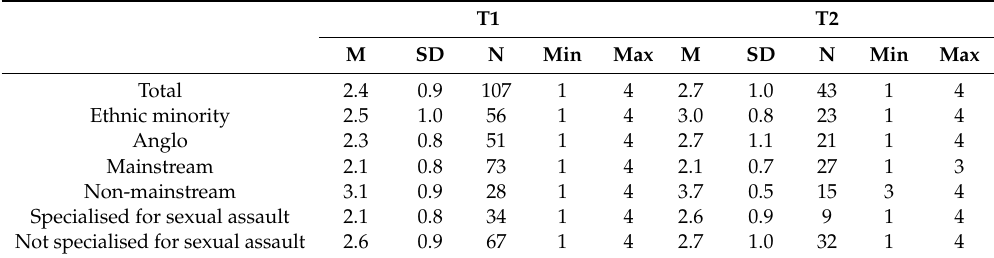
Table 8. Descriptive data on links with local CALD community organisations. T1